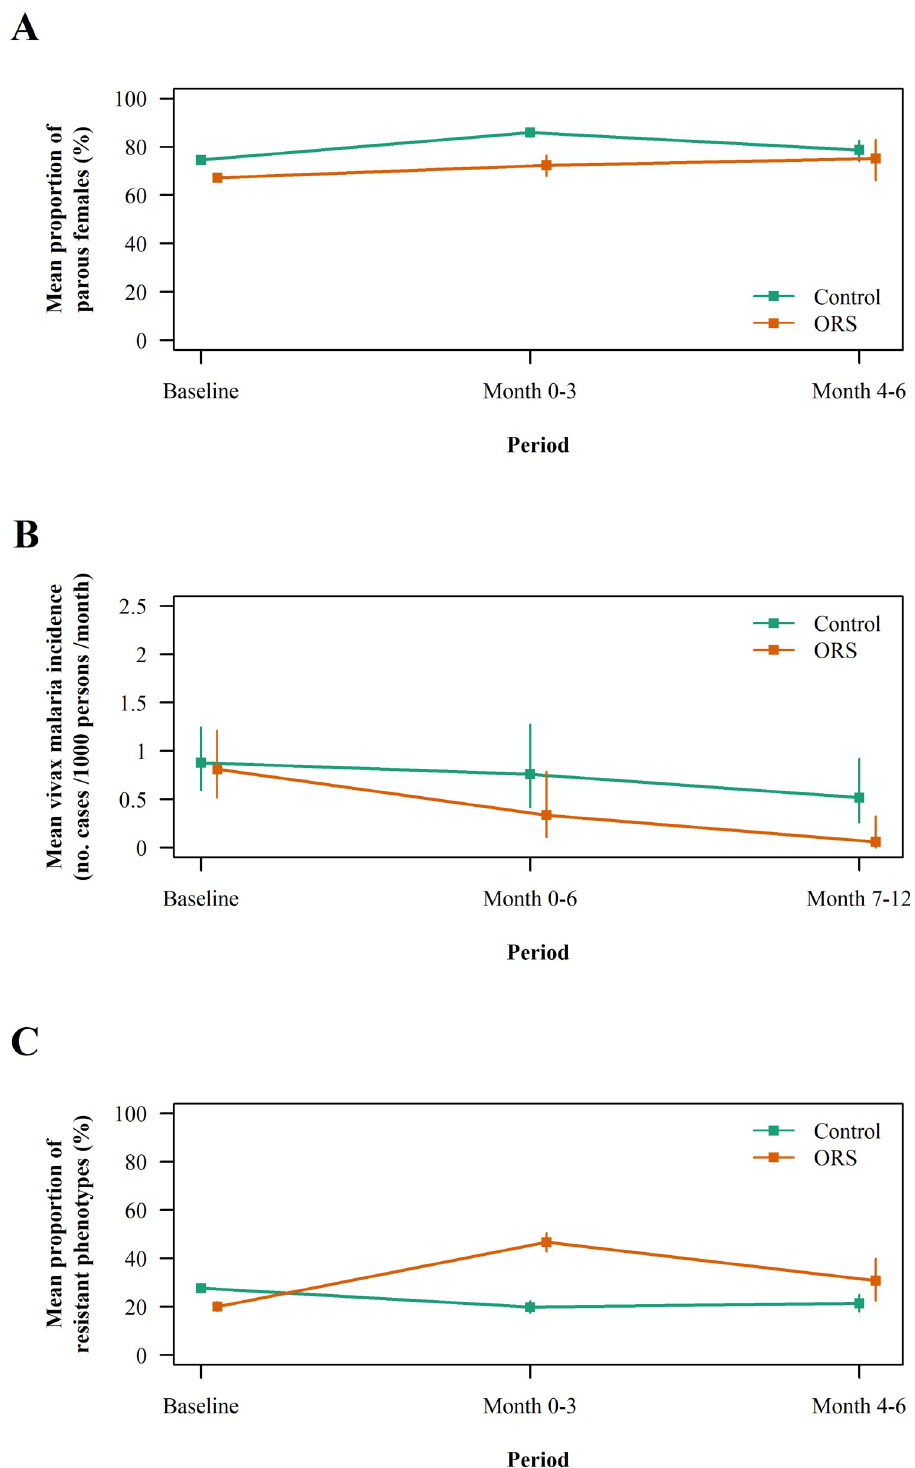
Fig 3. Evolution of the secondary outcomes in the village of the ORS and no intervention groups. (A) Mean proportion of parous Anopheles females, (B) mean incidence of vivax malaria and (C) mean proportion of lambda- cyhalothrin resistant phenotypes in Anopheles of the control and sprayed villages during the study. Vertical bars show the 95% confidence intervals.